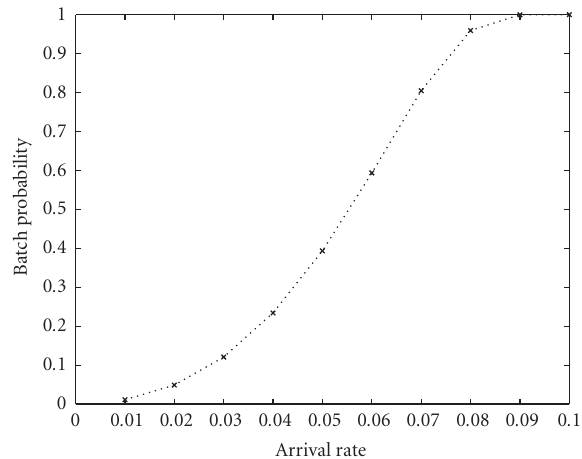
Figure 1: The batch probability of creating a VMG containing at least two collaborating clients, as a function of the expected arrival